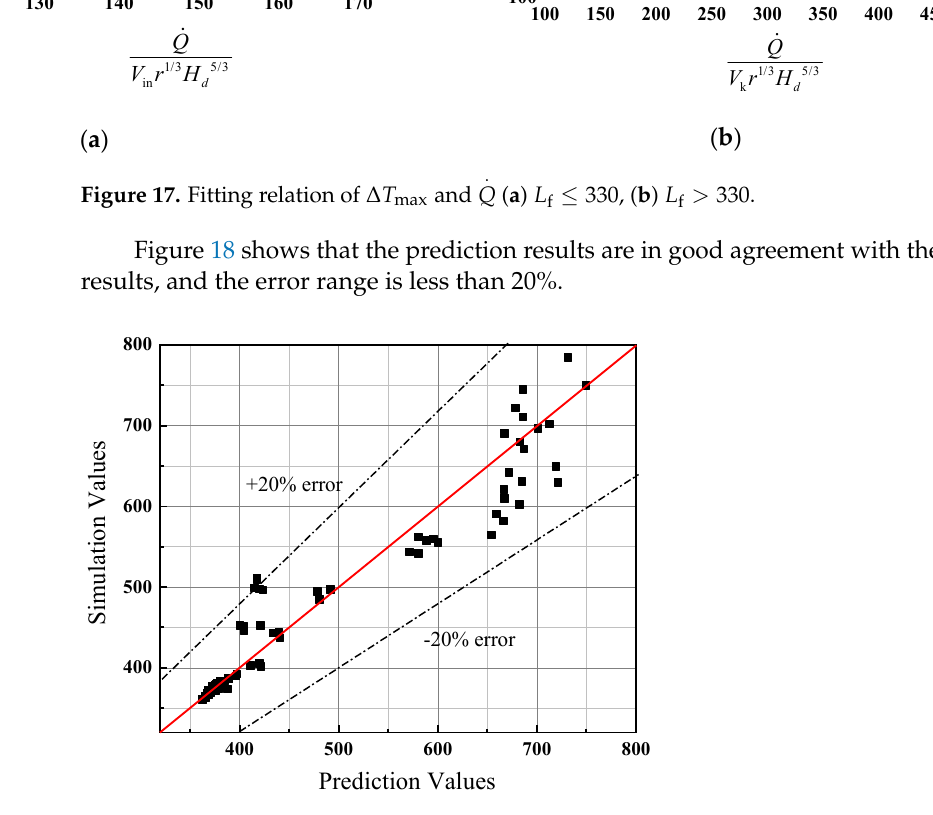
Figure 18. Comparison of numerically measured ∆ T max values and the predictions by Equation (27). The comparison between the simulation and prediction results of the distribution of the maximum smoke temperature under the tunnel ceiling when L f = 150 m and L f = 450 m is shown in Figure 19. The predicted results are consistent with the simulation results, and the error range is less than 20%.